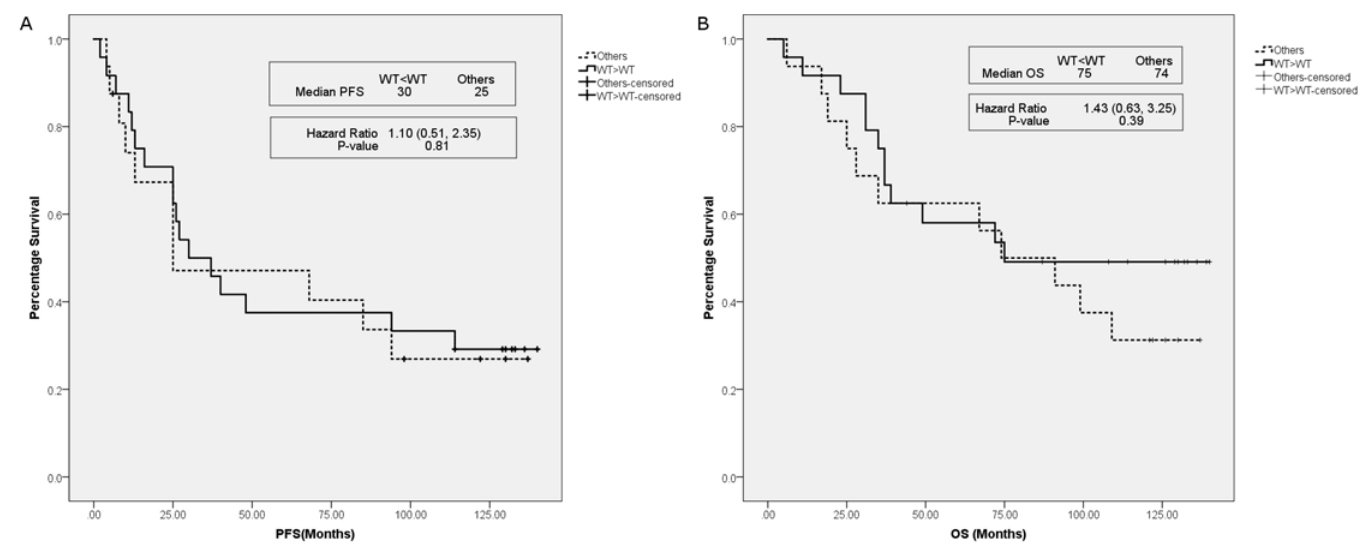
Fig 4. Progression-free and overall survival between the WT ! WT subgroup versus combination of other mutation pattern subgroups. (A) Progression-free survival and (B) overall survival of the WT ! WT subgroup and a combination of other mutation pattern subgroups (MT ! MT, MT ! WT, WT ! MT). Bold line: WT ! WT subgroup; broken line: combination of the other mutation subgroups MT ! MT, MT ! WT, WT !